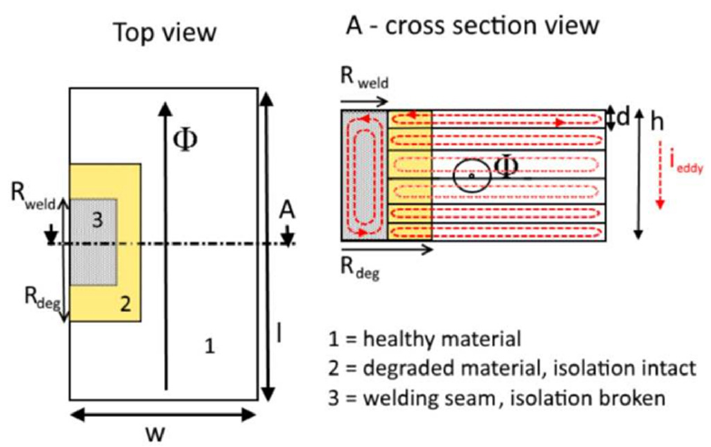
Figure 2. Top view and cross section view of a welded stack of laminations. Welded and degraded region are simplified to a rectangular area.